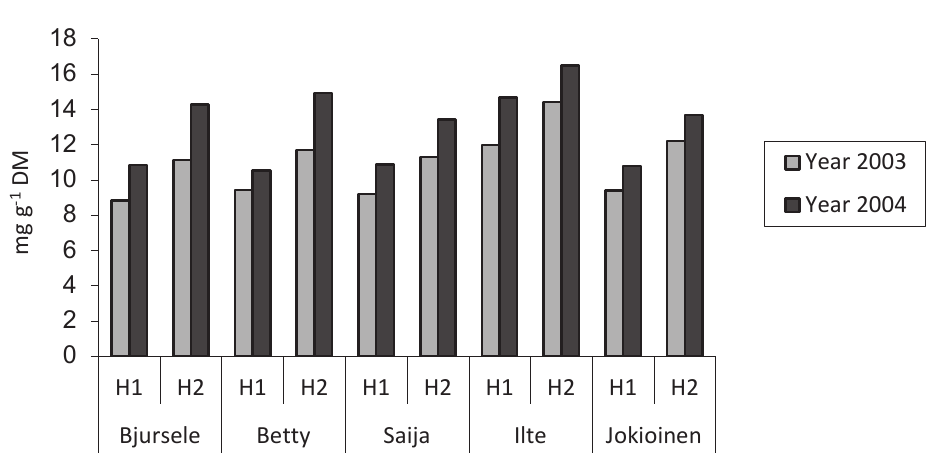
Fig. 1. The total isoflavone concentration (mg g -1 dry matter) for different red clover varieties at first (H1) and second (H2) harvest in 2003 and 2004